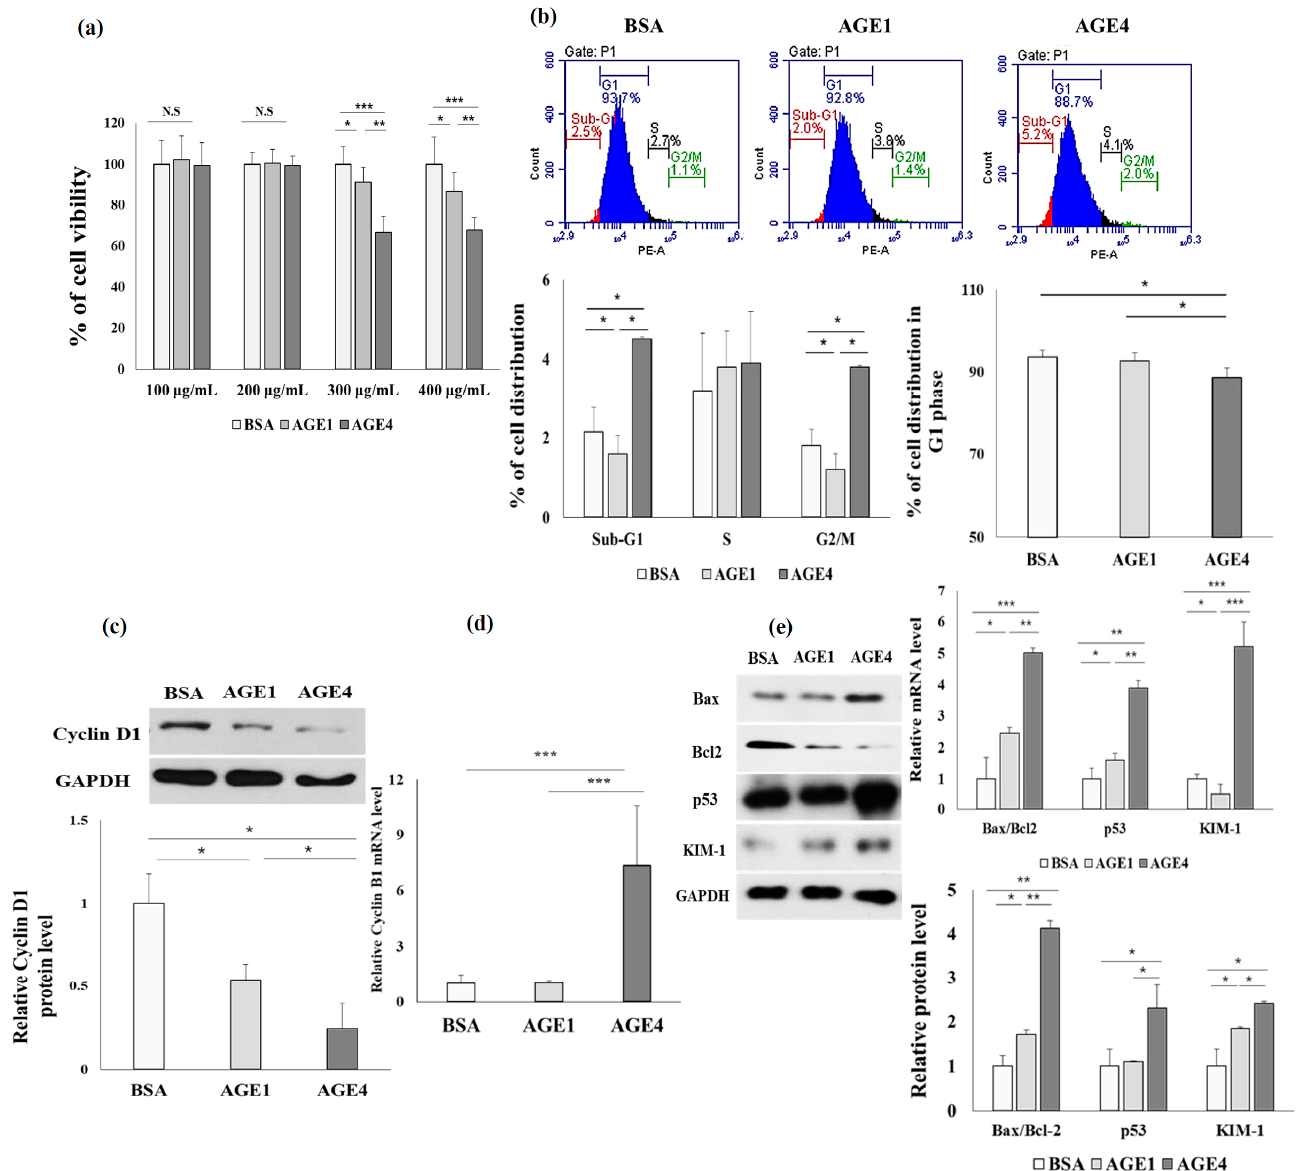
Figure 1. Effect of AGE4 treatment on HK-2 cells. ( a ) In HK-2 cells treated with AGE4, cell viability was determined using the MTT assay. ( b ) After staining with propidium iodide (PI), flow cytometry was used to analyze the cell cycle of HK-2 cells treated with 200 μ g/mL of AGEs. The effect of AGE4 on the cell cycle was measured based on the distribution of cells in the sub-G1, G1, and G2/M phases. Red segment: sub-G1 phase of apoptosis; blue segment: G1 phase of cell development; and black segment: S phase of DNA synthesis. ( c ) The expression of cyclin D1 protein by AGE4 was investigated using Western blotting. Densitometric analysis was performed using ImageJ (NIH, Bethesda, MD, USA), and the ratio of the expression of the target protein to that of GAPDH was calculated. ( d ) The mRNA expression of cyclin B1 was detected by quantitative RT-PCR (q-RT-PCR). ( e ) The protein and mRNA expression levels of Bax/Bcl2, kidney injury molecule_1 (KIM-1), and p53 were detected by Western blotting and q-RT-PCR. Data are expressed as the mean ± standard deviation (SD) of three independent experiments. The groups were compared using a Student’s t -test, and the levels of statistical significance are indicated as follows: * p < 0.05, ** p < 0.01, and *** p < 0.001.